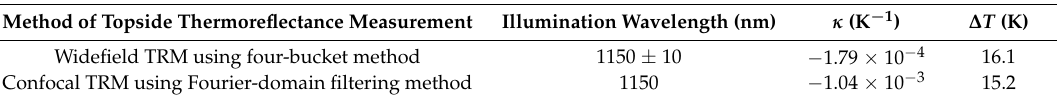
Table 1. Summary of the illumination wavelength, κ , and ∆ T for two methods of obtaining topside thermoreflectance images of the poly-Si micro resistor.